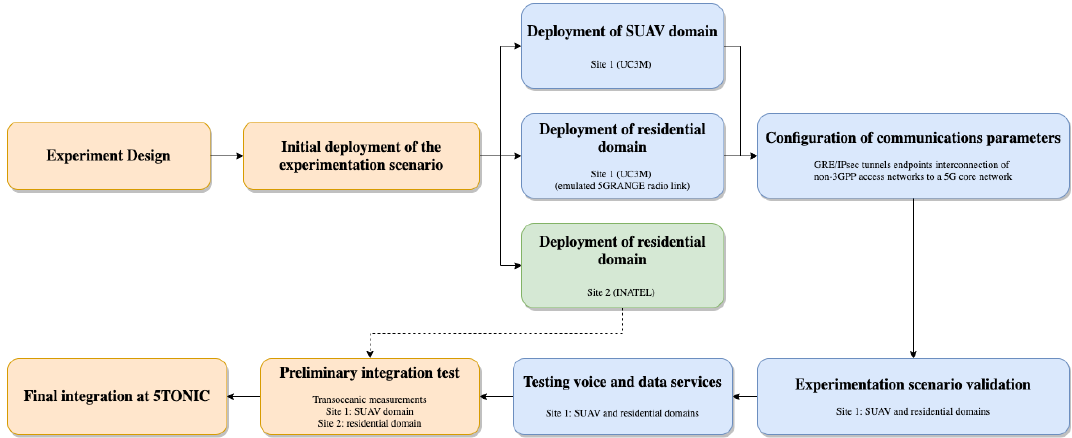
Figure 3. Methodology to define, deploy, integrate and validate the experimentation scenario.